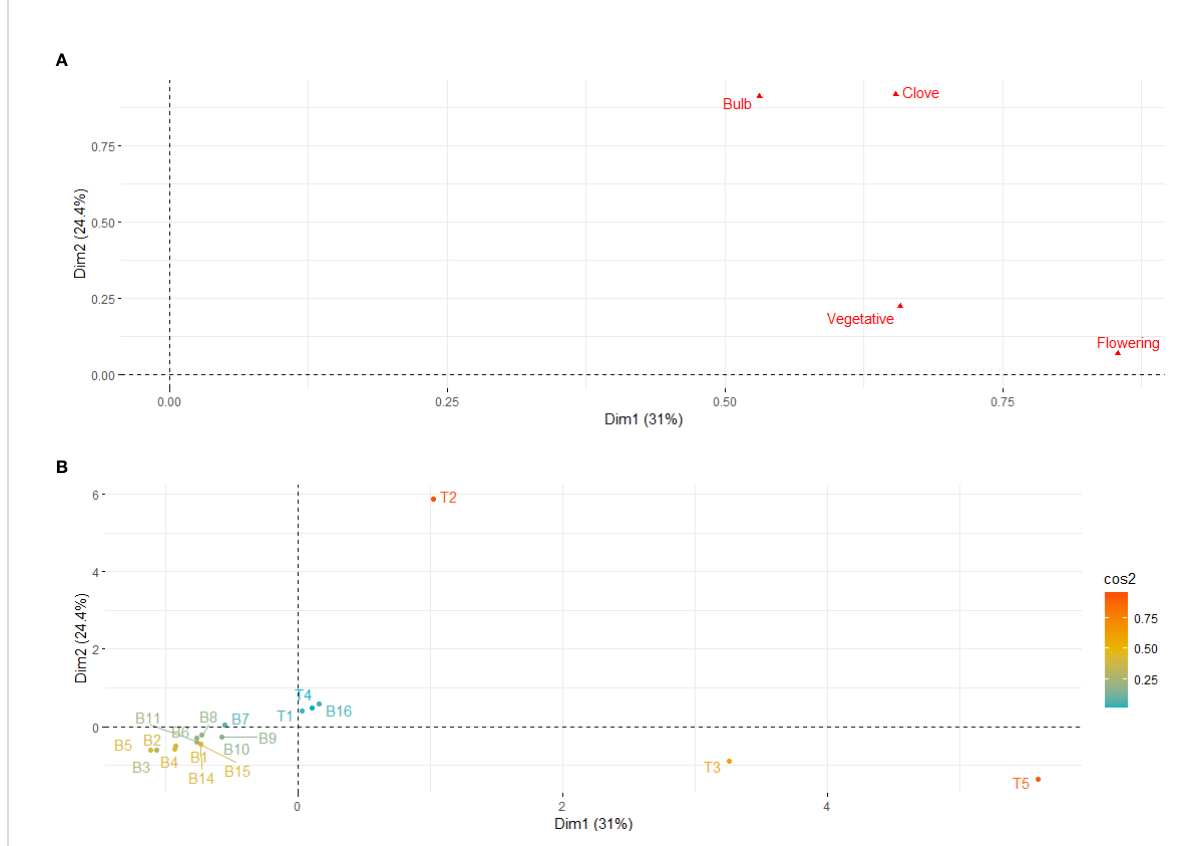
FIGURE 4 Multiple Factorial Analysis (MFA) of qualitative traits. Dim1-Dim2 scatterplots performed on qualitative variables related to vegetative, fl owering, bulb and clove traits. (A) contributions of groups of traits to the different dimensions; (B) position of the accessions in the Dim1-Dim2 scatterplot. B1-B16, Belltall traditional accessions; T1-T5, controls. Dim,